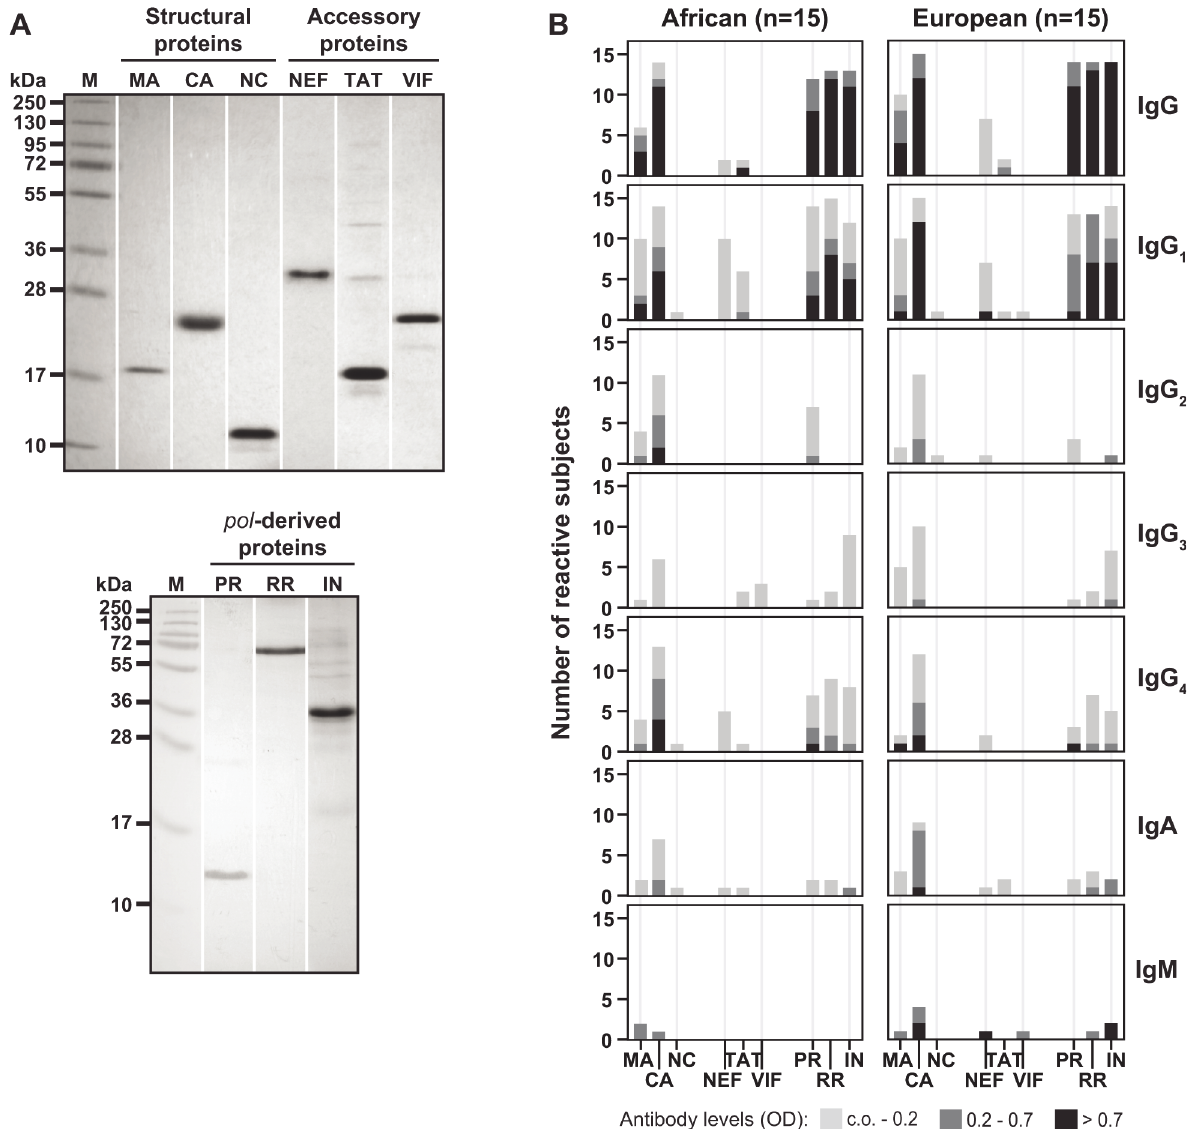
Fig 3. Purity and immunoreactivity of recombinant HIV-1 clade C structural, accessory and pol -derived proteins. (A) Coomassie-stained SDS-PAGE containing recombinant matrix (MA), capsid (CA), nucleocapsid (NC), NEF, TAT, VIF, protease (PR), reverse transcriptase+RNAseH (RR), integrase (IN) and molecular weight markers (M). Molecular weights (kDa) are indicated on the left. SDS-PAGE analysis of NEF was performed on a separate gel with identical molecular weight marker as for structural and accessory proteins. (B) Frequencies and intensities (y-axes: number of reactive sera; OD levels color- coded) of IgG, IgG subclass, IgA and IgM responses of African (left) and European (right) patients to structural, accessory and pol -derived proteins